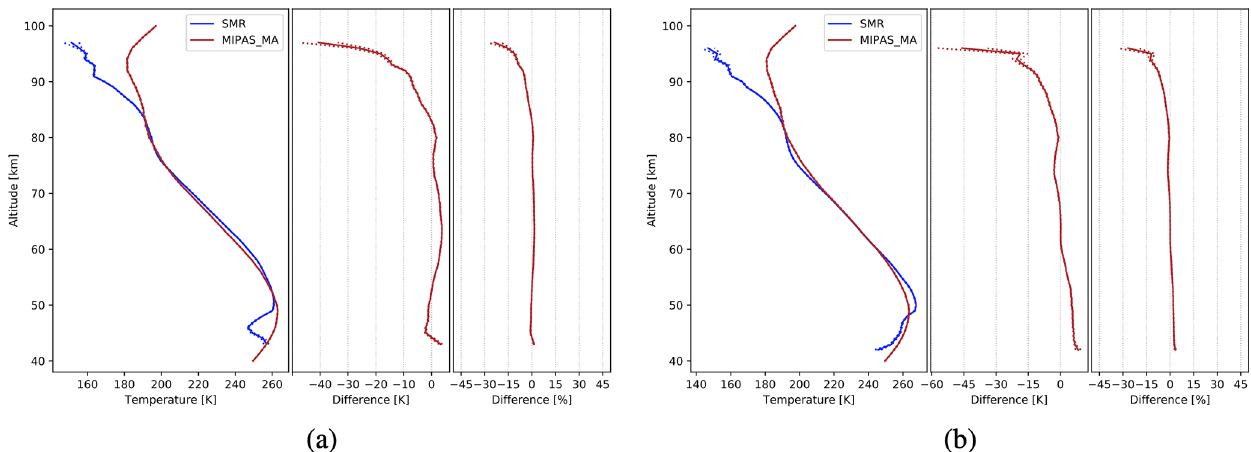
Figure A20. Comparison of SMR temperatures, from FM13 (a) and FM19 (b) , with those from MIPAS middle atmosphere mode retrievals. The data plotted are global averages over the whole time periods indicated in Table 2. Figure characteristics are the same as in Fig. 6.